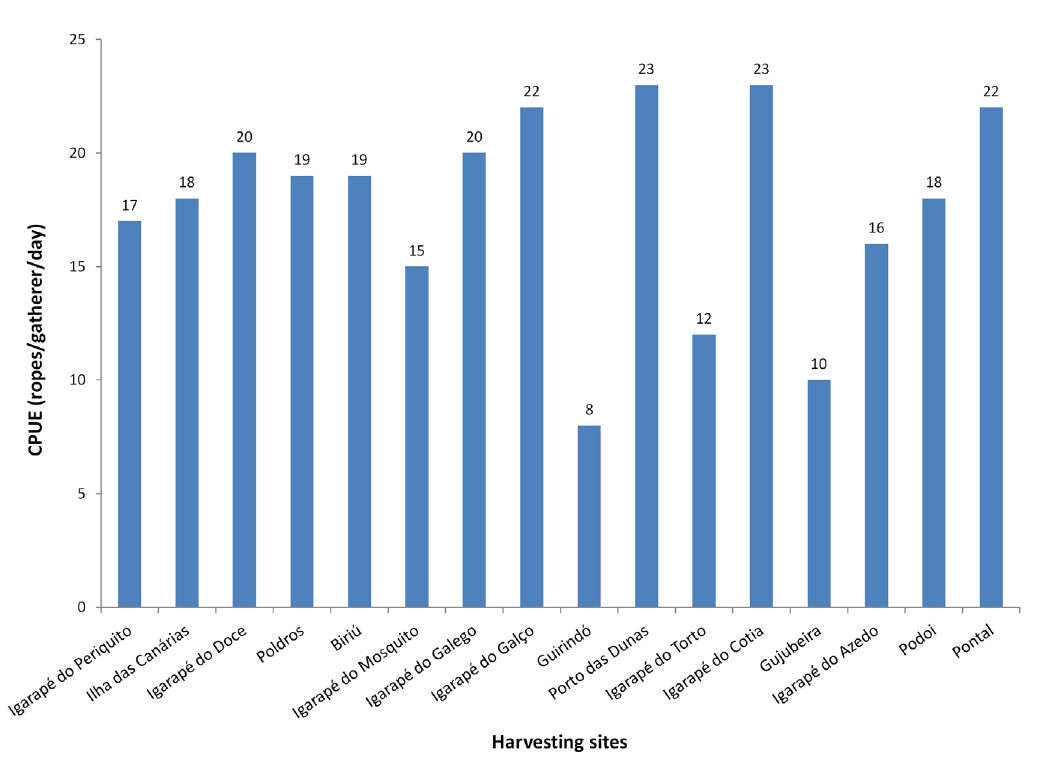
Figure 5. CPUE (ropes / gatherer / day) for the Ucides cordatus harvesting sites in the Parnaíba River Delta, Brazil. N = 84.